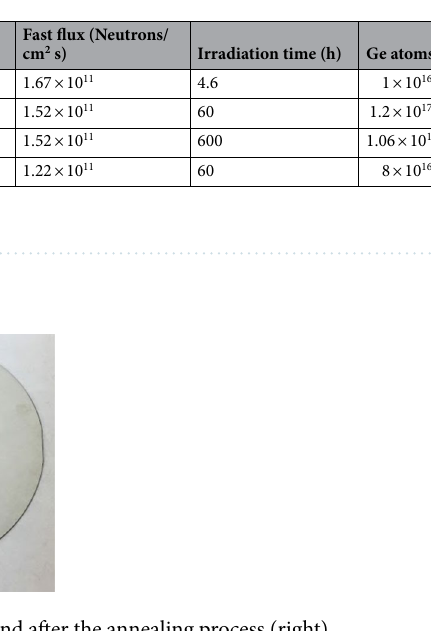
Figure 1. A 2 ″ GaN wafer after irradiated for 60 h (left) and after the annealing process